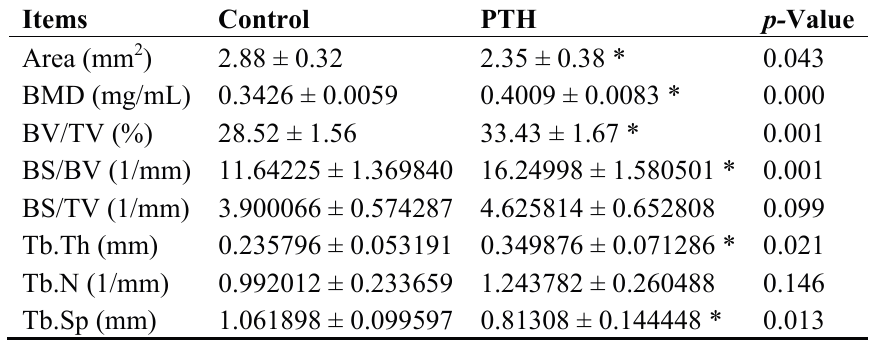
Table 2. Micro-CT evaluation (mean ± SD). BMD, bone mineral density; BV, bone volume; BS, bone surface; Tb.Th, trabecular thickness; Tb.N, trabecular number; Tb.Sp, trabecular separation; * indicates significant difference between